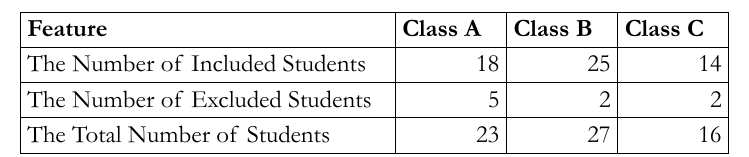
Table 3. The Statistics of Introductory Programming Classes